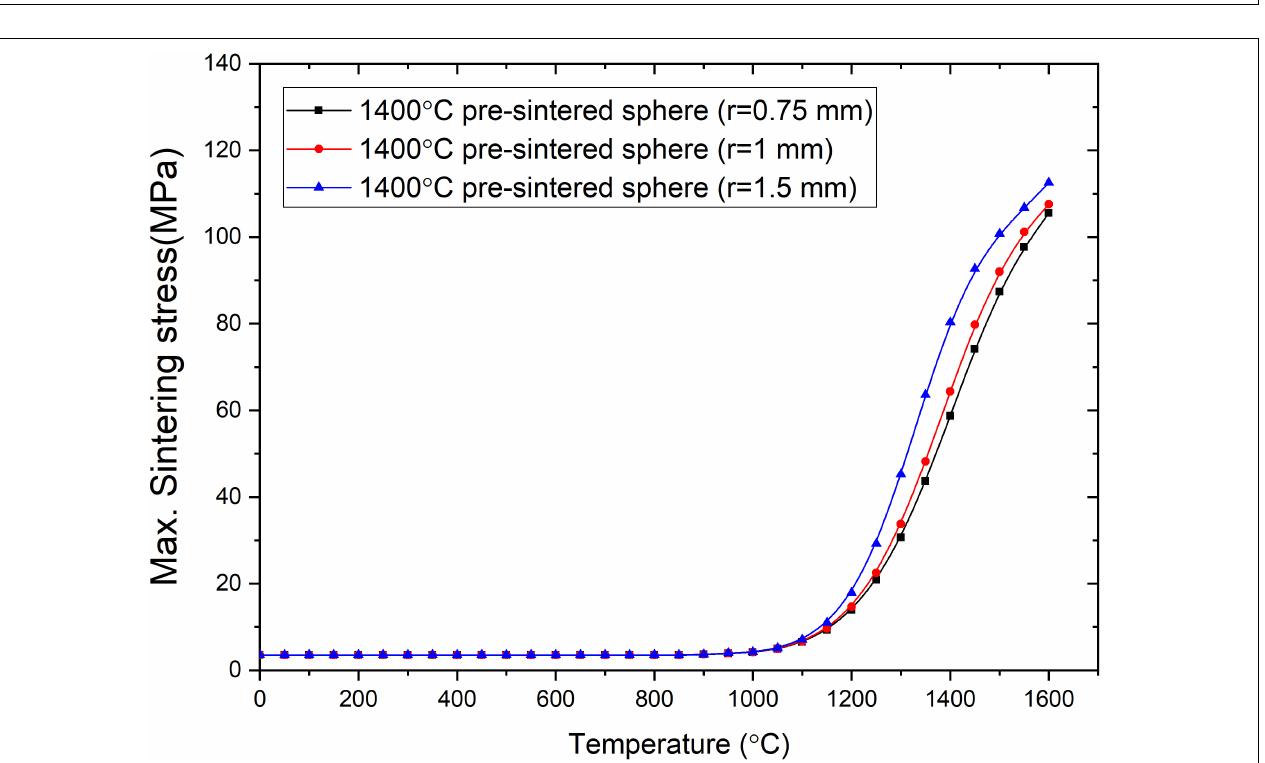
FIGURE 9 | FEA-calculated maximum sintering stress in UO 2 pellets containing lumped Gd 2 O 3 spheres of different sizes but equal shrinkage rates.